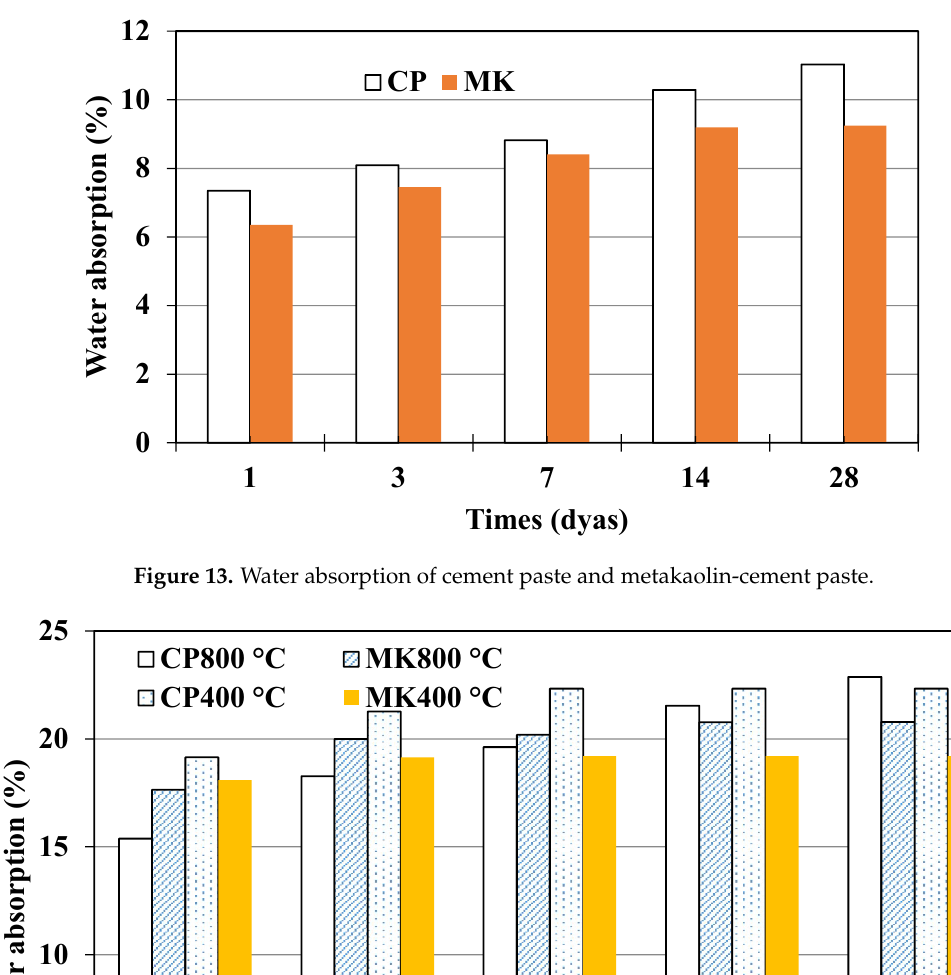
Figure 12. Mass change of cement paste and metakaolin-cement paste under the water absorption test after elevated temperature exposure.